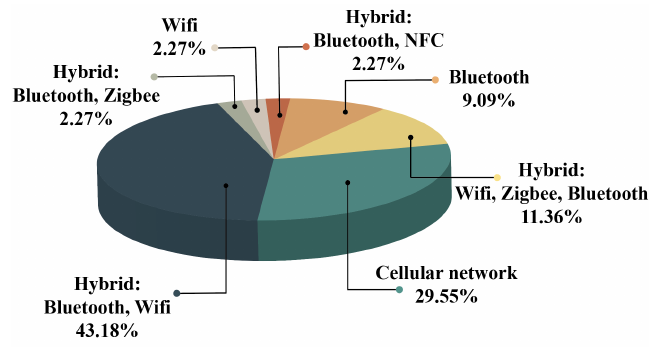
Figure 12. Networking